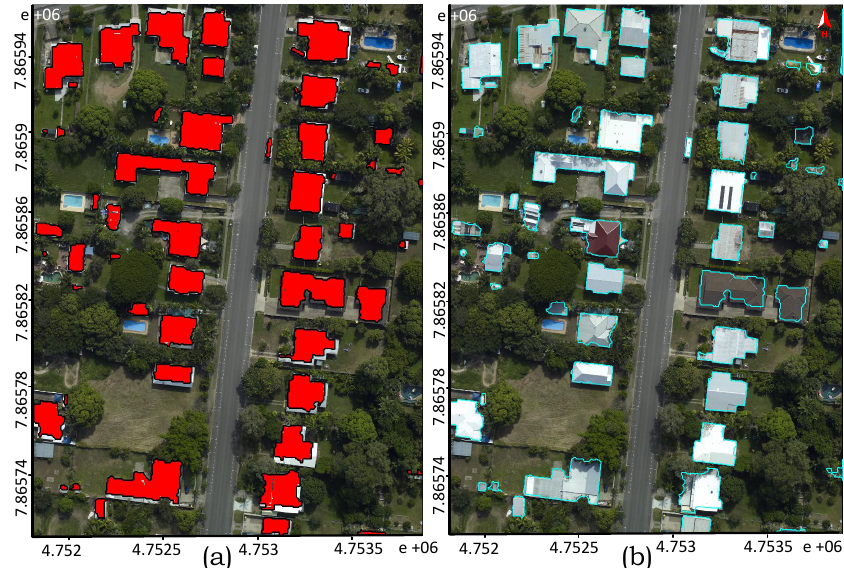
Figure 10. ( a ) Building boundaries before enlargement (Under detected edges with black boundary and red region); ( b ) Final detected buildings after enlargement (cyan